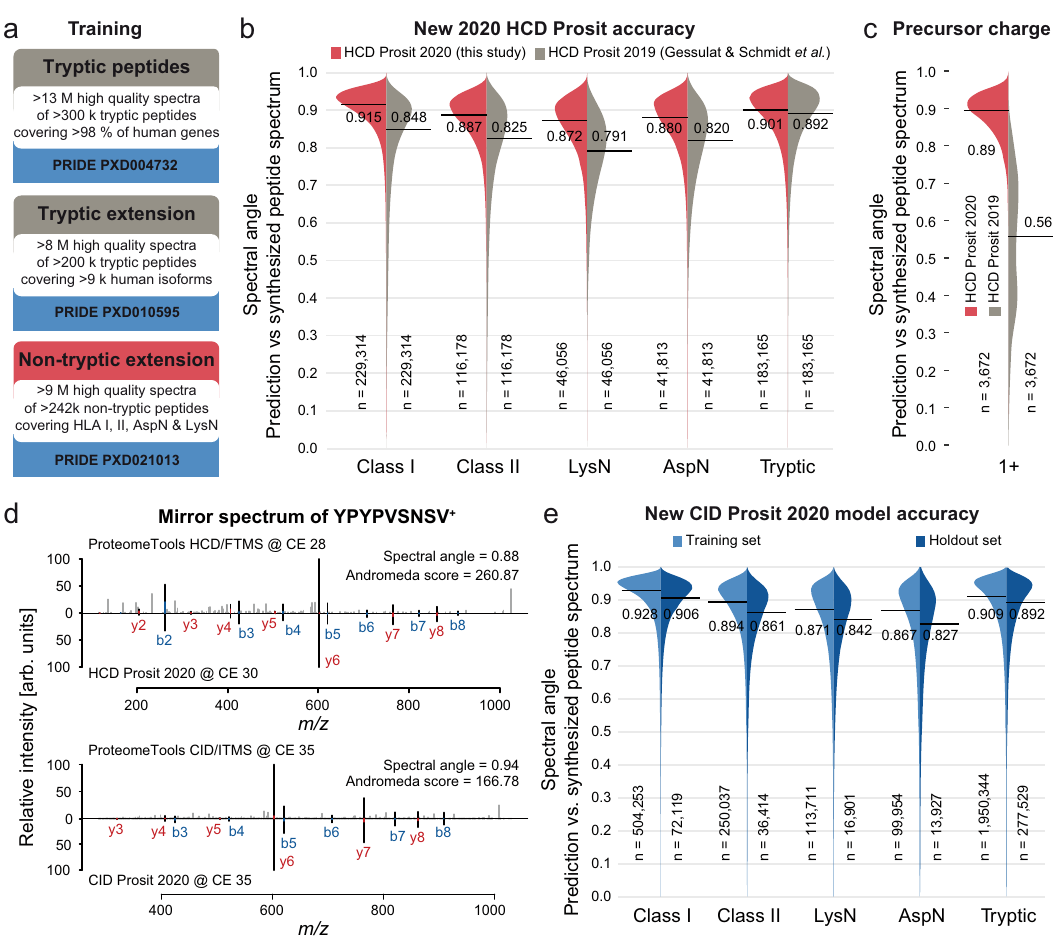
Fig. 2 Deep learning framework Prosit for tryptic and non-tryptic peptide fragment intensity prediction. a The deep learning framework Prosit was trained on data available prior to this study (tryptic peptides, top panel; tryptic extension, middle panel) and data on non-tryptic peptides (bottom panel) generated in this study. b Beanplots comparing the prediction accuracy of the HCD Prosit 2020 model (red, this study) against the prediction accuracy of the previously published HCD Prosit 2019 model (gray, tryptic only, Gessulat and Schmidt et al. 7 ) for the four introduced peptides sets (HLA class I, HLA class II, LysN, and AspN) and the previously published tryptic peptides. The number of underlying spectra (n) is indicated at the bottom. The black solid line and corresponding numbers indicate the median spectral angle for each distribution. c Beanplot comparing the prediction accuracy of the HCD Prosit 2020 model (red, this study) against the HCD Prosit 2019 model (gray, Gessulat and Schmidt et al. 7 ) for singly charged peptides. The number of underlying spectra is indicated at the bottom. The black solid line and corresponding numbers indicate the median spectral angle for each model. d Mirror spectrum of the singly charged non-tryptic peptide YPYPVSNSV comparing the experimentally acquired HCD ProteomeTools spectrum (top panel, top spectrum) to its predicted spectrum by the HCD Prosit 2020 model (top panel, bottom spectrum) and the experimentally acquired CID ProteomeTools spectrum (bottom panel, top spectrum) to its predicted spectrum by the CID Prosit 2020 model (bottom panel, bottom spectrum). Fragment ions are labeled in blue and red for b- and y-ions, respectively. Matching peaks (present in both spectra) are visualized in black, whereas peaks only present in the top (experimental) spectra are colored in gray. Red and blue fractions of matching peaks indicate the normalized difference in intensity between the experimental and predicted spectra. e Beanplots comparing the prediction accuracy of the CID Prosit 2020 model between the training (light blue) and holdout (dark blue) set for the four introduced peptides sets (HLA class I, HLA class II, LysN, and AspN) and previously published tryptic peptides. The number of underlying spectra (n) is indicated at the bottom. The black solid line and corresponding numbers indicate the median spectral angle for each distribution. Raw and analysis data are available from the PRIDE repository with identi fi ers PXD004732, PXD010595, and